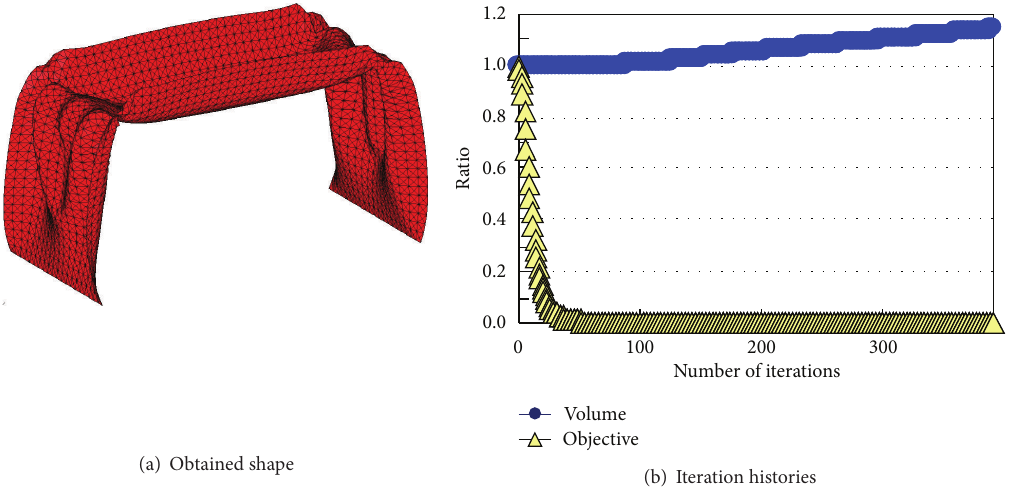
Figure 10: Optimization results of table-shaped model (350 Hz).